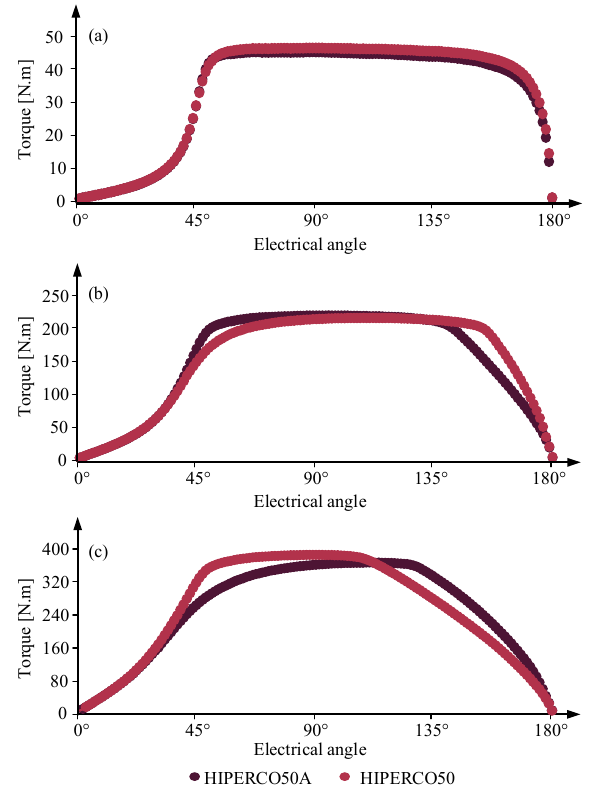
Figure 2. Comparison of static torque production with HIPERCO ® 50 and HIPERCO ® 50A for the dimensional constraints and current density levels of LSA SRM: ( a ) J = 5 A/mm 2 , ( b ) J = 15 A/mm 2 , and ( c ) J = 25 A/mm 2 .